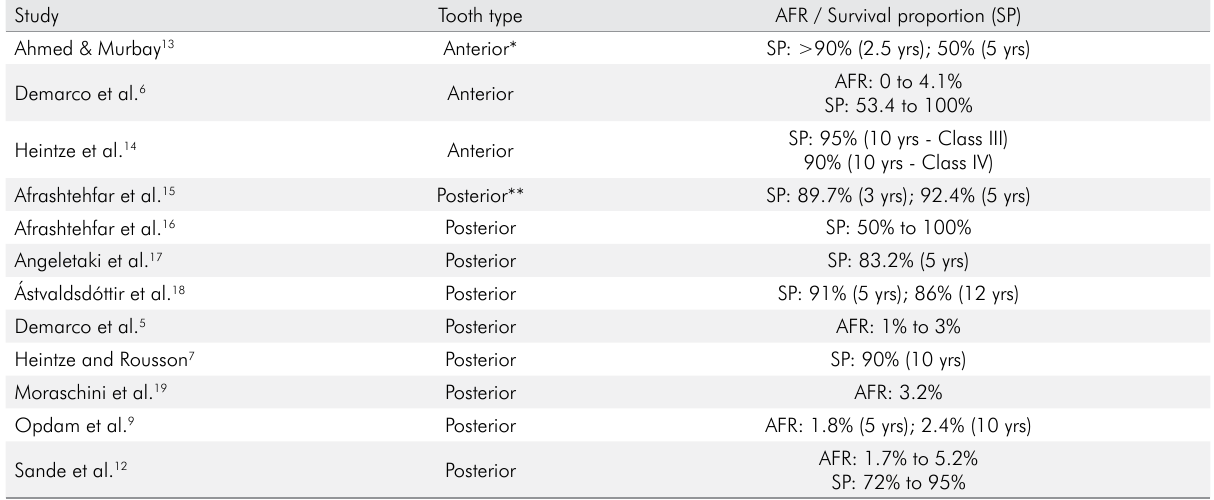
Table. Systematic reviews on longevity of direct composite restorations published in the last 5